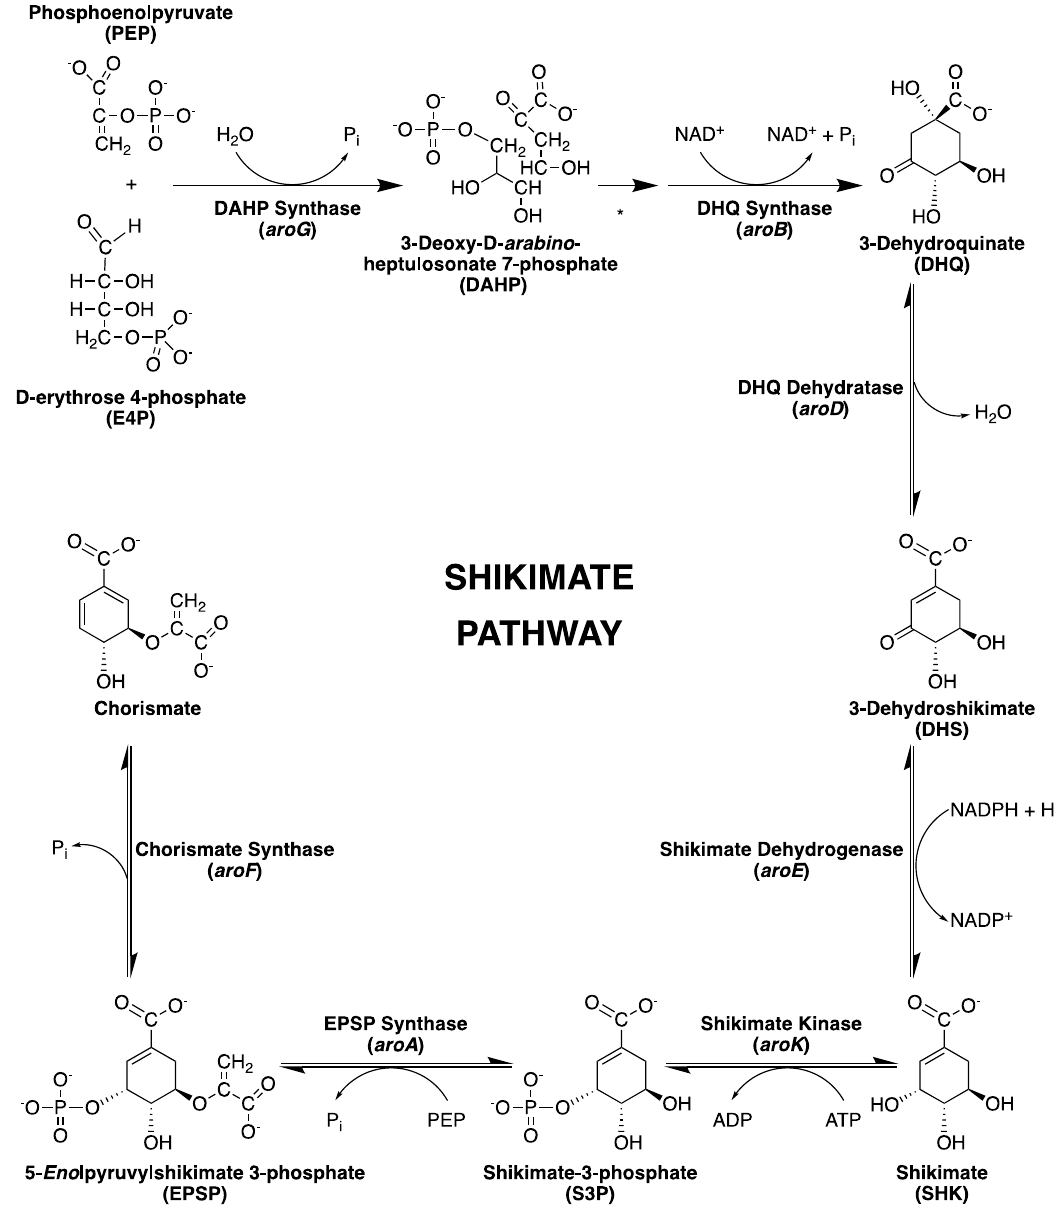
Figure 1. The shikimate pathway. The gene coding for each enzyme is in parenthesis. * Spontaneous cyclization of 3-deoxy- D -arabino-heptulosonate 7-phosphate (DAHP). P i = inorganic phosphate.